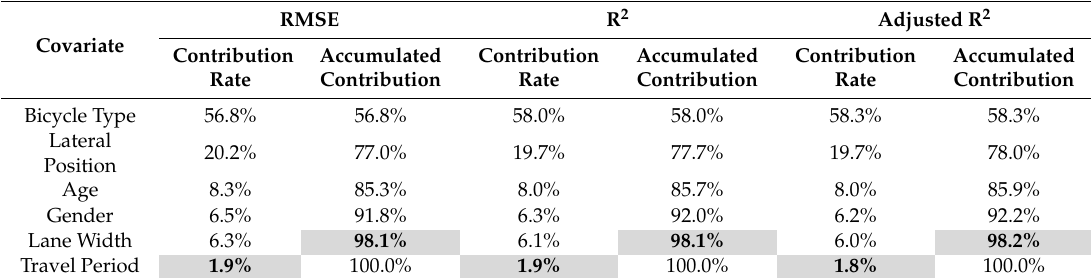
Table 5. Contributions of Selected Factors to Goodness of Fit of the GLM Model.